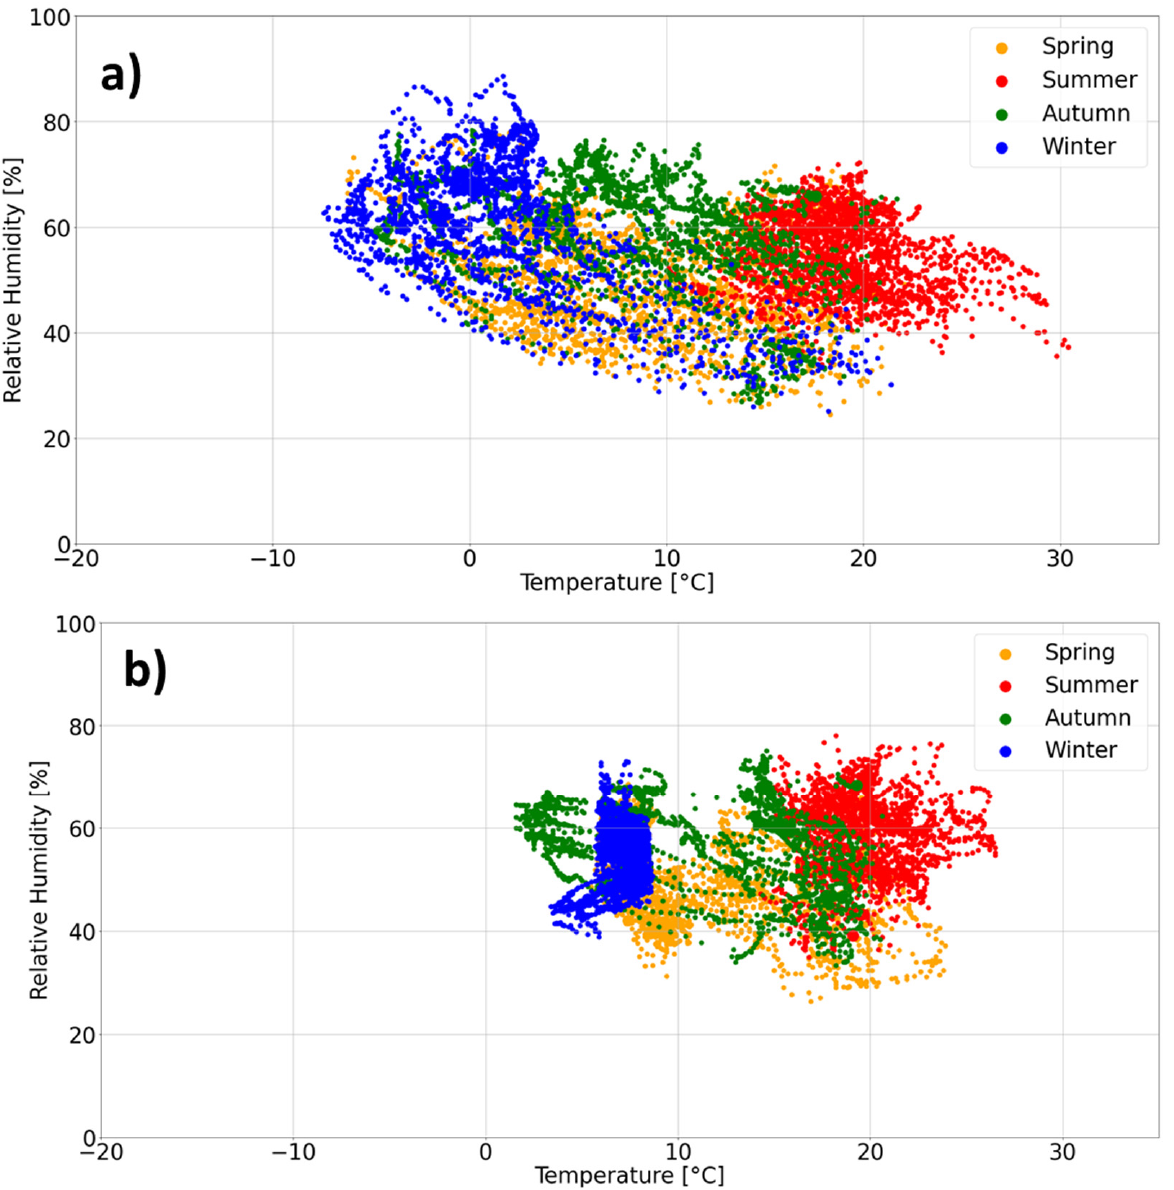
Figure 2. RH vs. T ellipses of data collected in Ringebu church ( a ) and Heddal church ( b ) from March 2019 to March 2021. The different colours represent the different seasons of the calendar year, according to the legend.